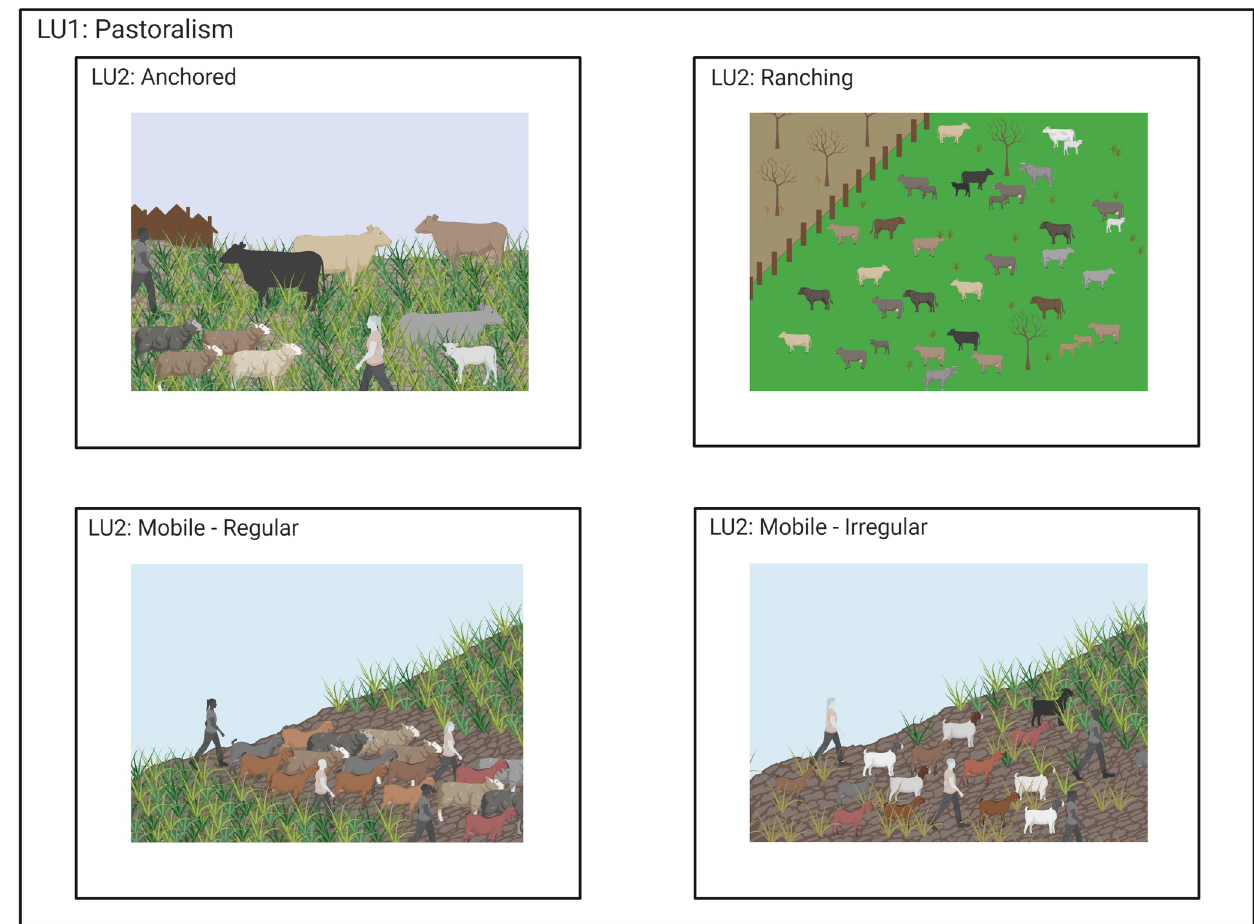
Fig 6. LU1-“pastoralism” shown as several LU2 categories: LU2-“anchored pastoralism” shown as cattle and sheep in proximity to a settlement. LU2- “ranching” shows cattle enclosed in pasture land away from wild/unmanaged lands. LU2-“mobile–regular” shows sheep and goats being led along a specific path. LU2-“mobile–irregular” shows sheep and goat being moved along in a less regular pattern along a less well trodden path. Created with BioRender.com, under a CC BY license, with permission from Biorender, original copyright 2020.